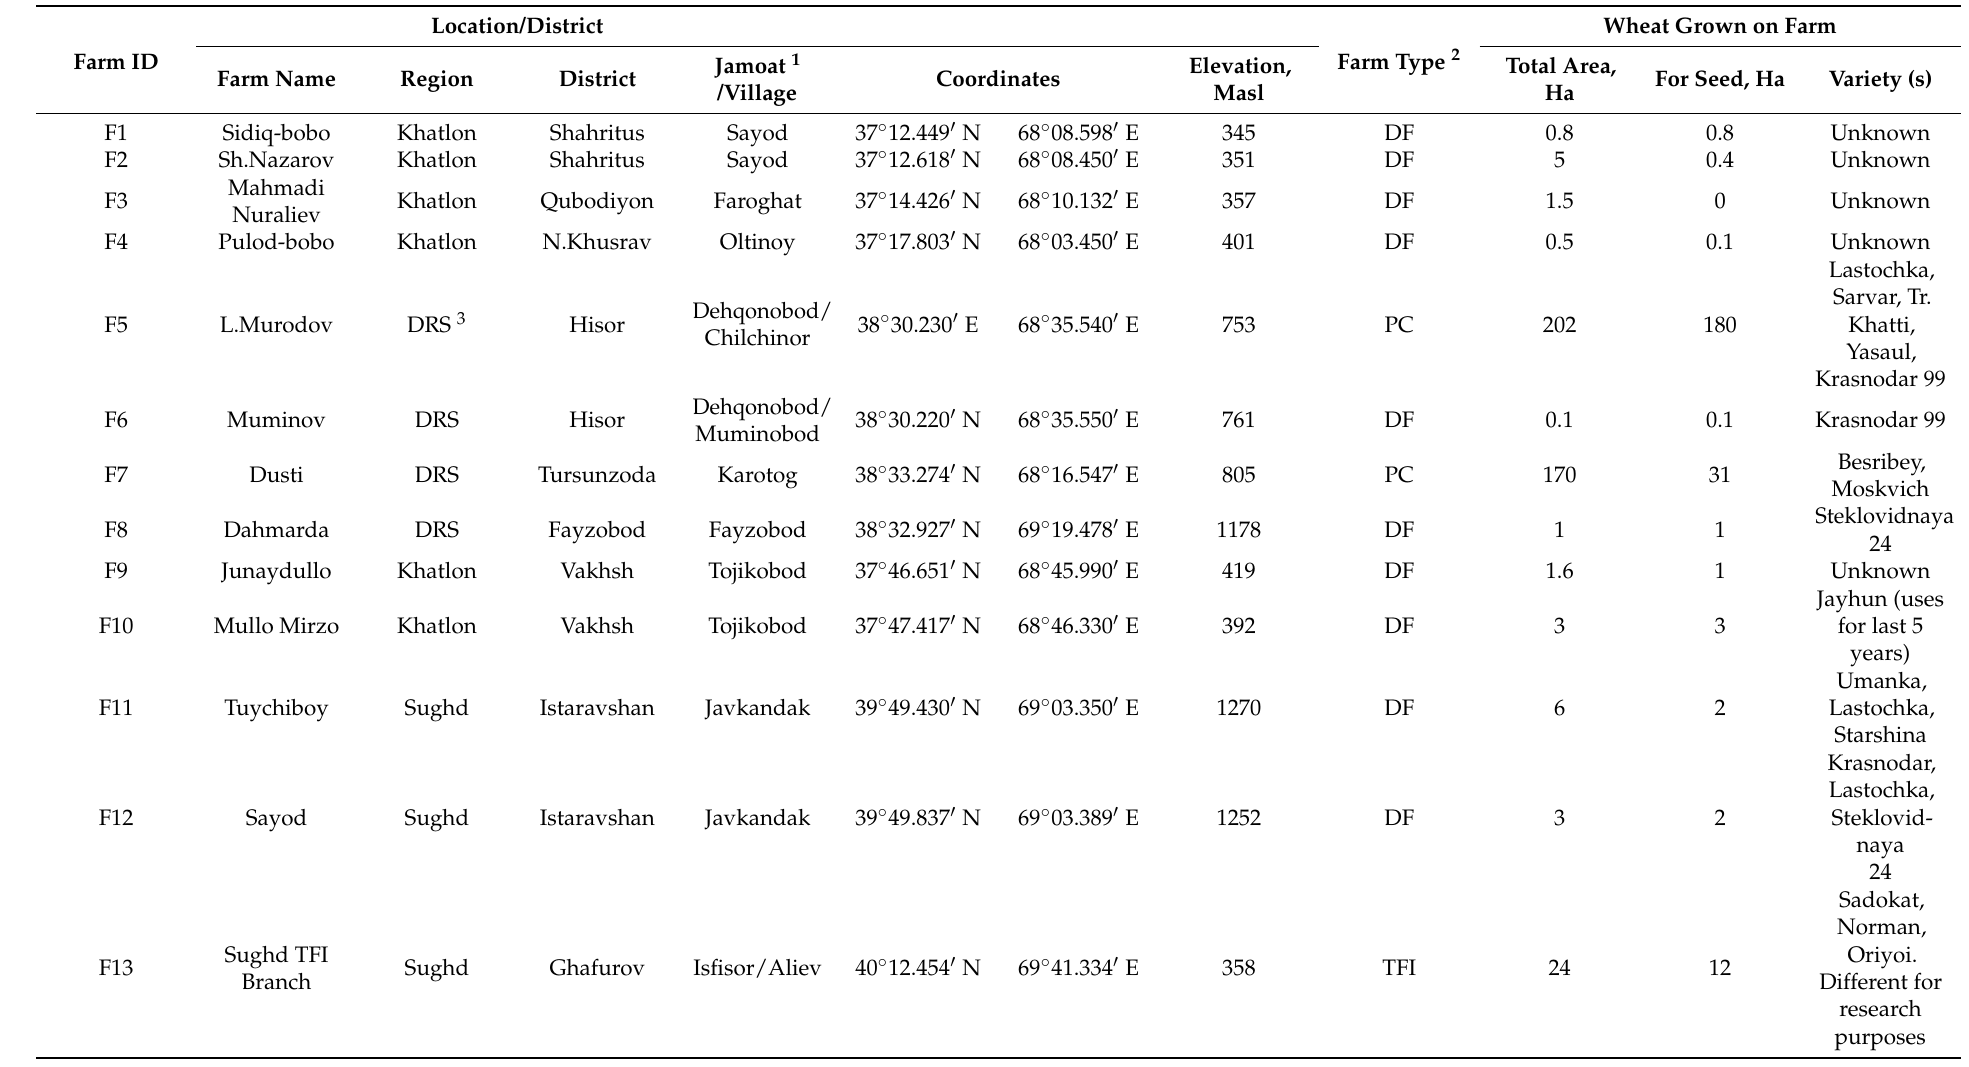
Table 1. Name, location, coordinates, planted area and wheat varieties on the 21 farms in Tajikistan surveyed in this study,